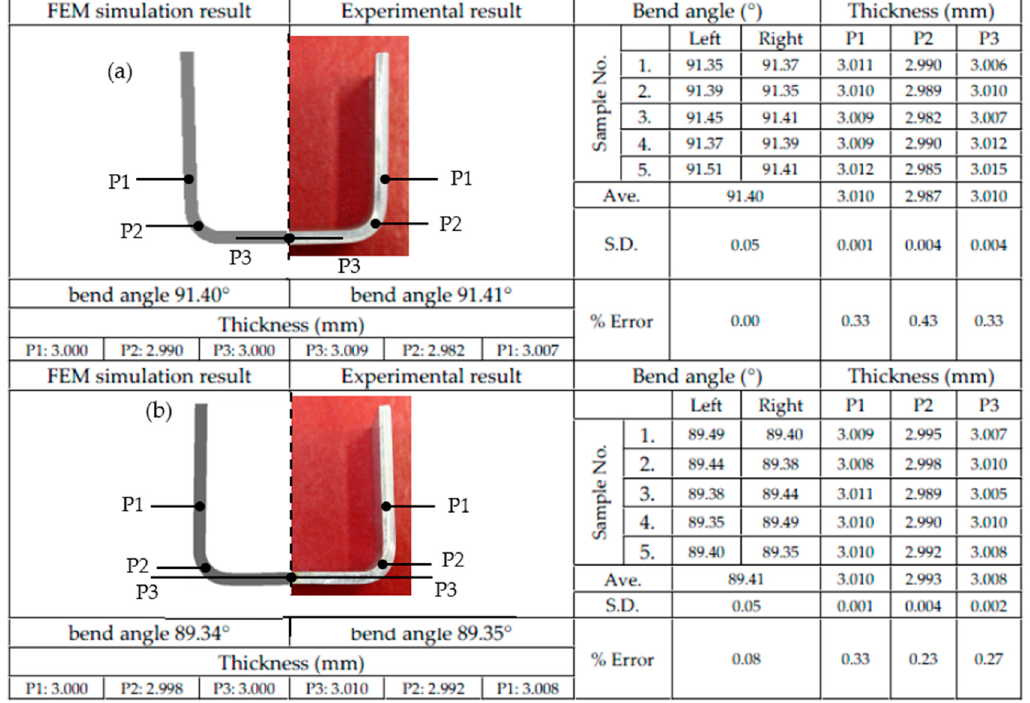
Figure 14. Comparison of the bent parts, obtained using FEM simulations and experiments: ( a ) with pressure pads; ( b ) without pressure pads ( θ : 90°, t : 3 mm, WP L : 120 mm, W : 40 mm, R p : 5 mm, R ud : 5 mm). SD: Standard deviation.